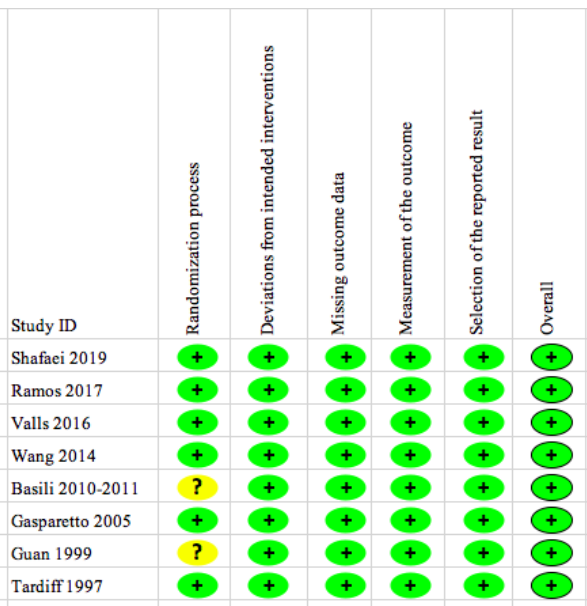
Figure 2. Risk of Bias of 8 Included Trials. The plus sign in green (+) shows “low risk” for bias and the question mark in yellow (?) shows “some concerns” for bias. None of the trials show “high risk” for bias.